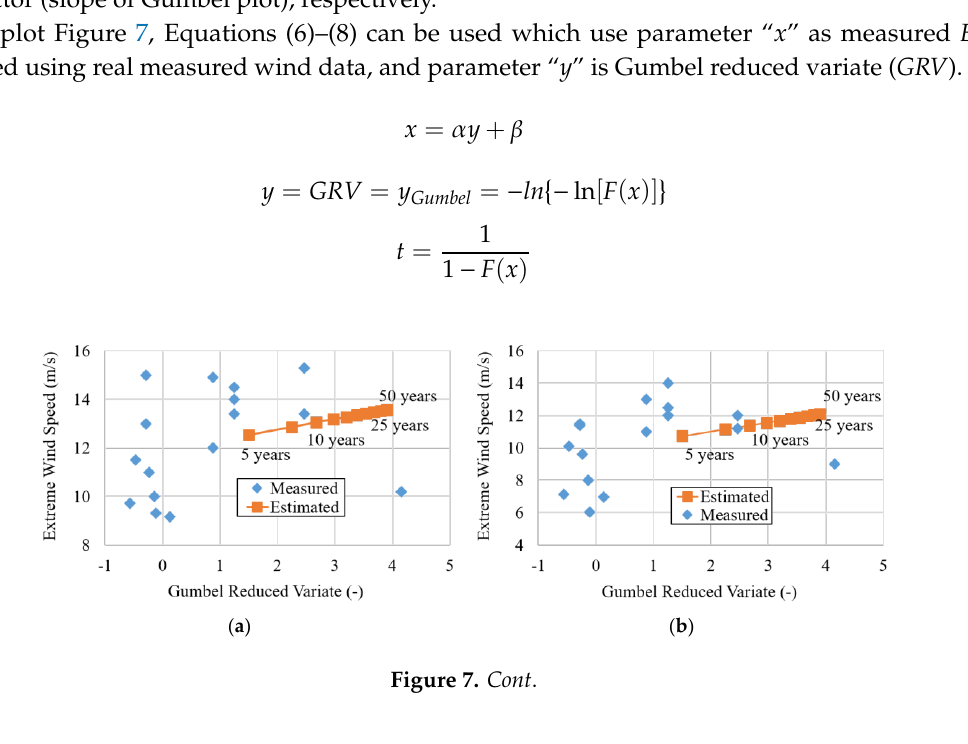
Table 4. International electrotechnical commission wind turbine categories.